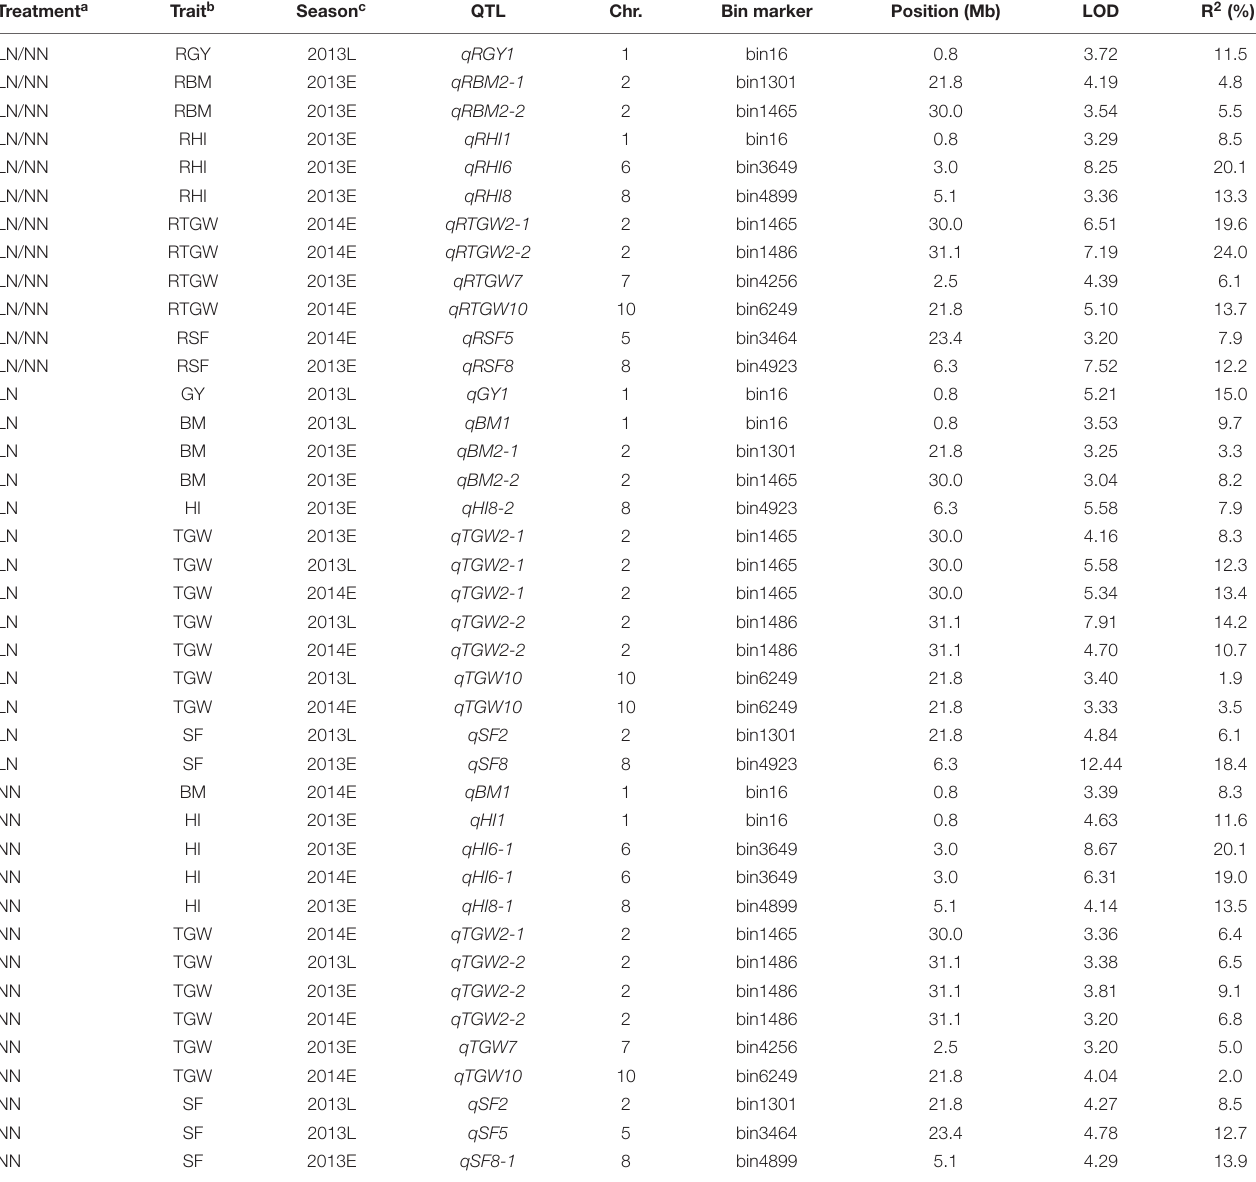
TABLE 2 | Putative QTLs for five NDT-related traits identified under LN, NN, and LN/NN conditions in three seasons. Treatment a Trait b Season